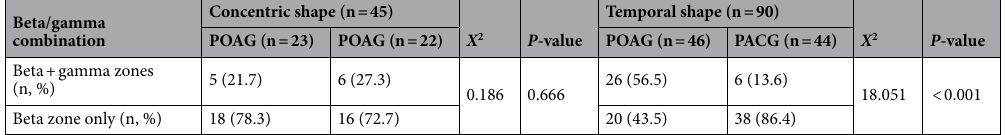
Table 5. The distribution of beta/gamma zone combination among concentric/temporal shape of parapapillary beta zone. PACG: primary angle-closure glaucoma; POAG: primary open angle glaucoma. Chi- square test was